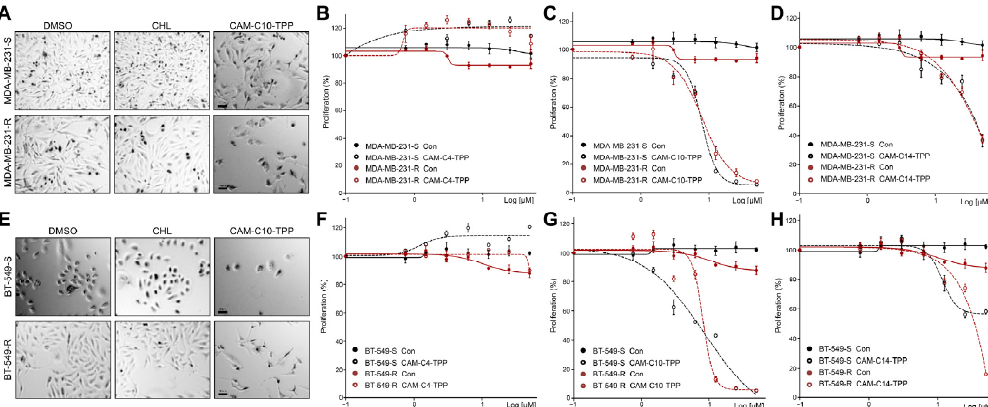
Figure 5. Effect of CAM-TPP derivatives on the cell viability of TNBC cells. MDA-MB-231 ( A – D ) and BT-549 ( E – H ) TNBC-sensitive (S) and chemoresistant (R) cells were grown at a 60% confluence for 3 days with the indicated concentrations of CAM-TPP derivatives. Representative images ( A , E ) were obtained at 40 × magnification. The scale bar is 10 µ m. Cells were subjected to viability assays. The results represent the mean of 3 independent experiments. The data indicate the mean ± SEM. The p -values, all relative to controls, were statistically significant ( p <